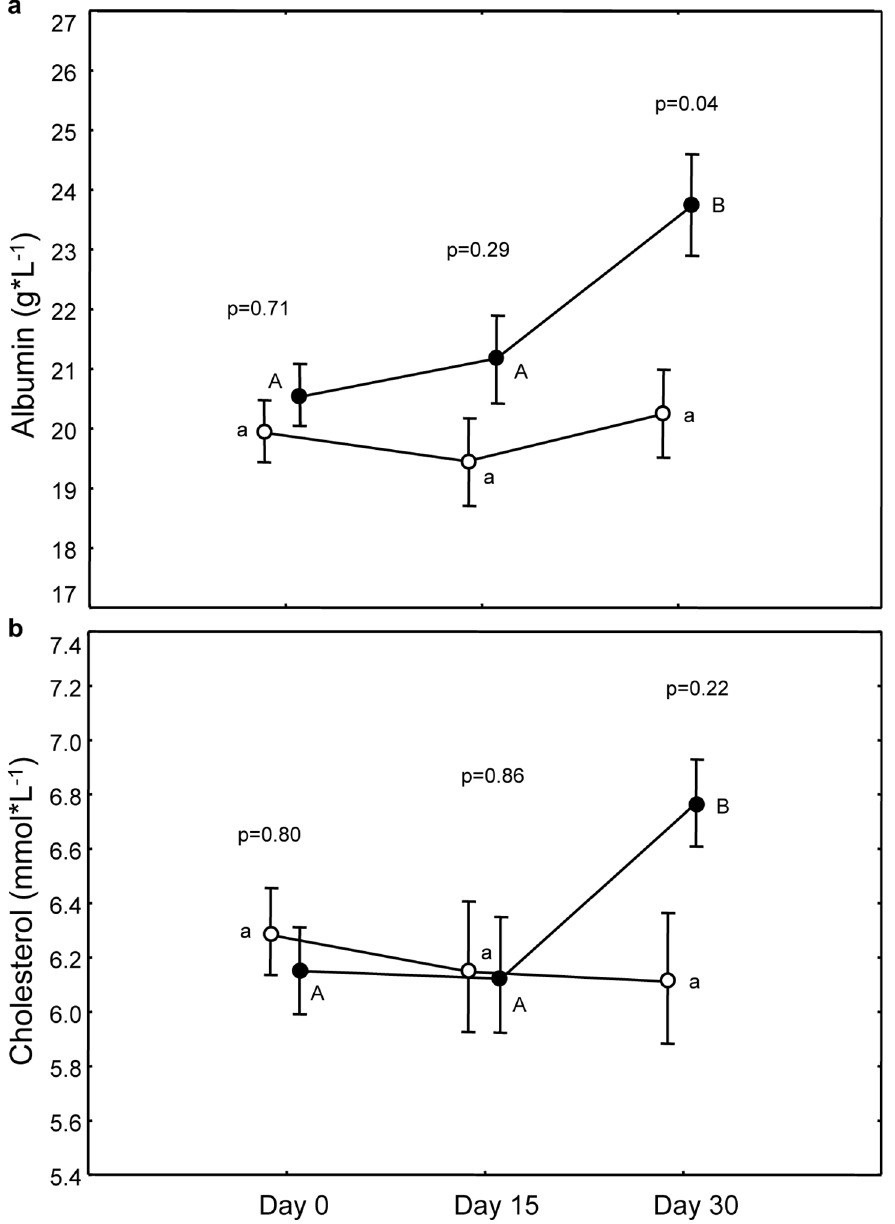
Fig. 3. Variation of albumin and cholesterol during time in the two treatments. Full circles represent Caro-birds. P values refer to pairwise differences of least square means between groups within the same day (reported only when significant) and within each group between different days (different letters indicate significant difference with what observed on day 0; capital for Caro-group and small letters for